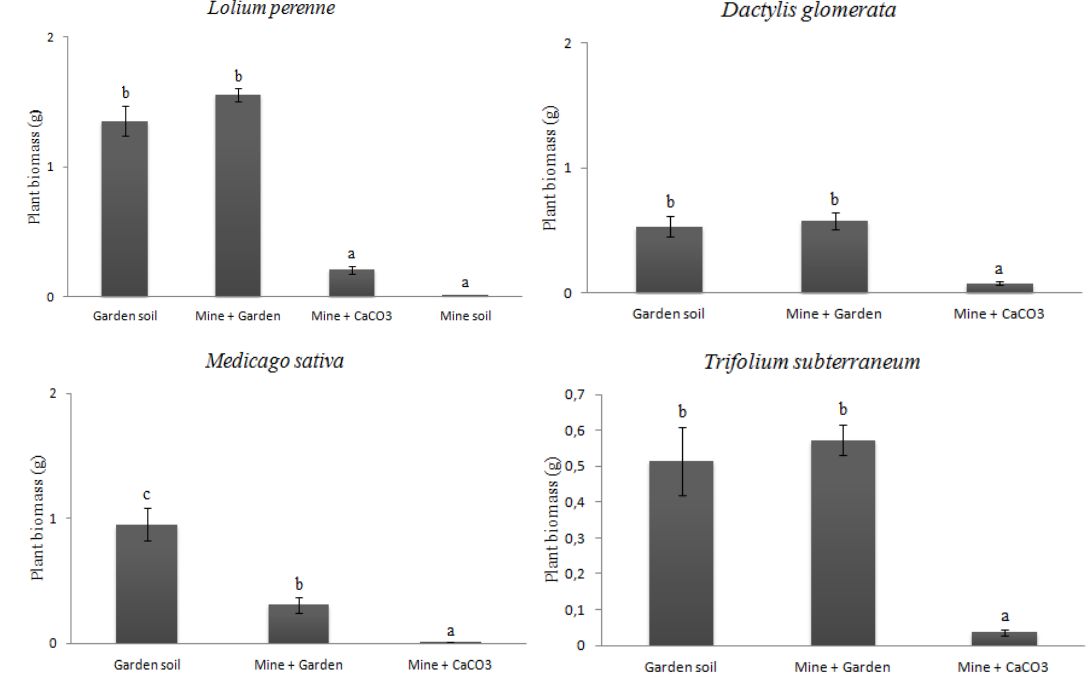
! Figure 5. Aboveground biomass (mean ± SE) in each treatment at the end of the mixture of species experiment. Di ff erent letters above the bars mean significant di ff erences between each soil type after ANOVA and Tukey post hoc